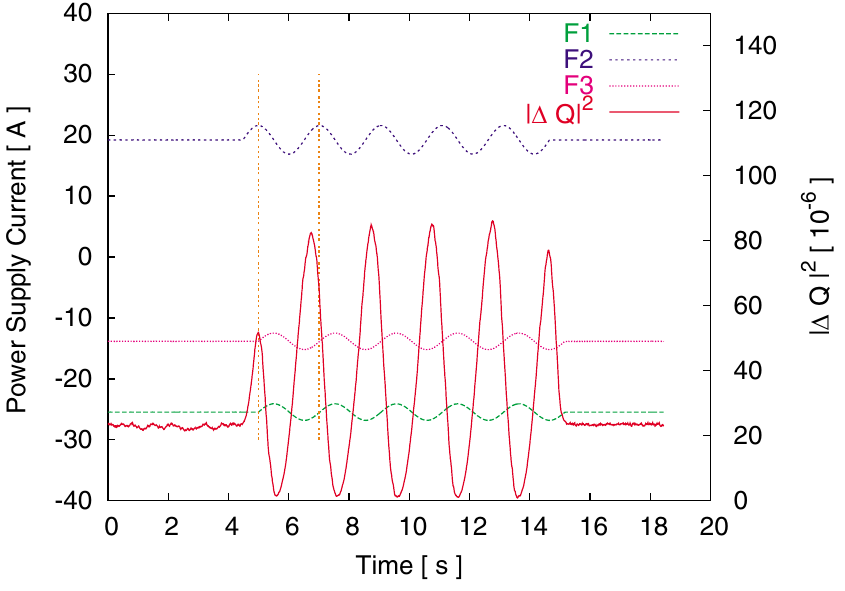
FIG. 3. (Color) The coupling correction strength searching.